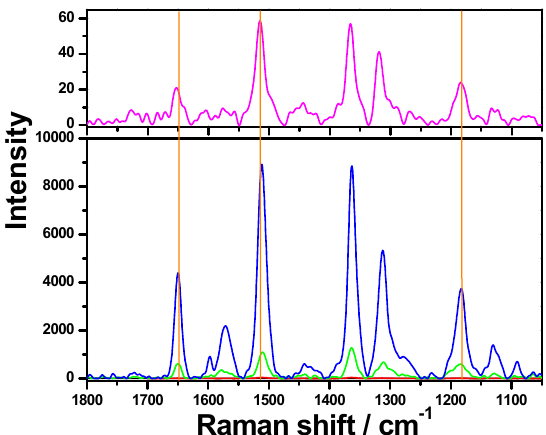
Figure 7. Raman spectra of Rh6G (1 × 10 − 4 M) deposited onto a silicon substrate (top magenta curve), NIF-H (black curve), MIF-H (red curve), NIF@GO-AgNPs (green curve), and MIF@GO-AgNPs sample (blue curve).